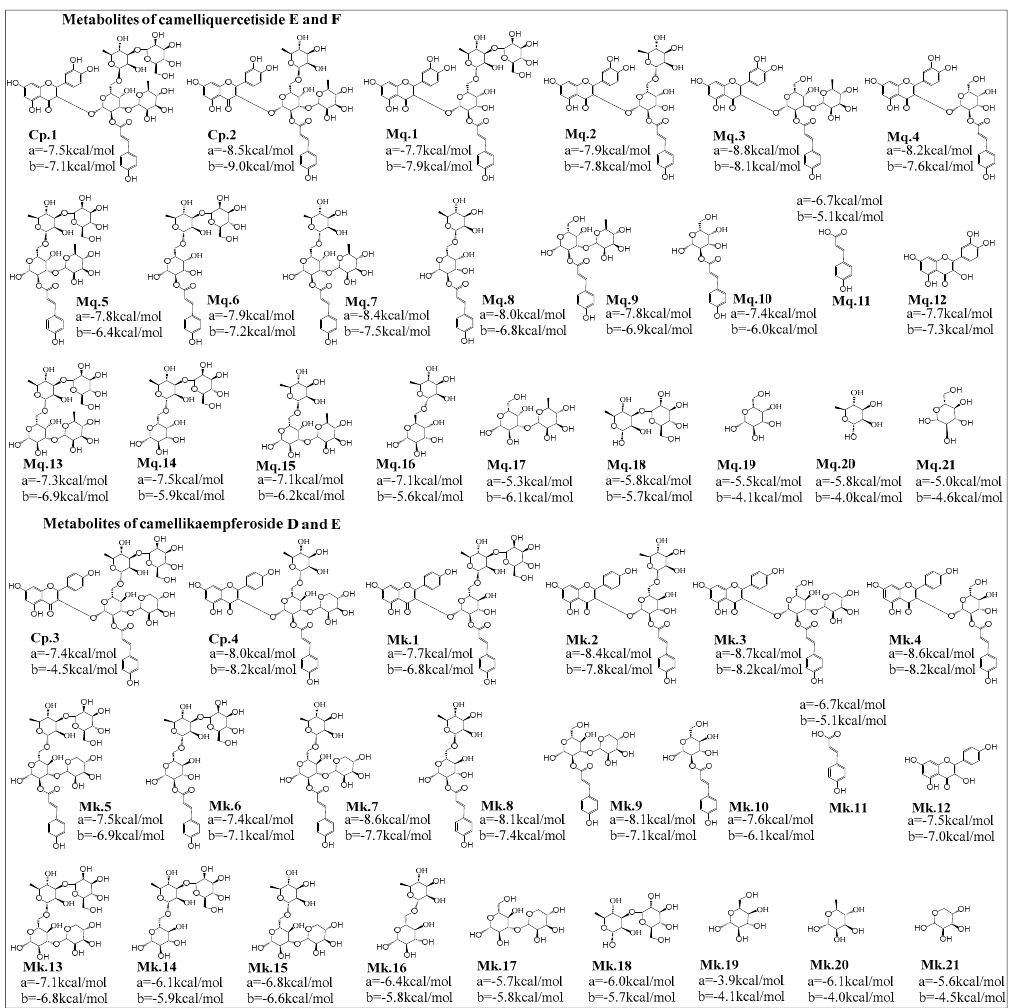
Figure 3. Proposed hydrolysis metabolites of acylglycosides flavones and docking score analysis of their inhibitory abilities on α - glucosidase ( a ) and HMG-CoA reductase ( b ). Among camelliquercetisides, metabolites Mq. 3 and prototype Cp. 2 (camelliquercetiside F) exhibited excellent inhibitory activities on α -glucosidase and HMG-CoA reductase at − 8.8 kcal/mol and − 9.0 kcal/mol, respectively. For camellikaempferosides, metabolites Mk.3 exhibited good inhibitory activities on α - glucosidase at − 8.7 kcal/mol, Cp. 4 , Mk. 3 and Mk. 4 were calculated as the good inhibitors on HMG- CoA reductase.